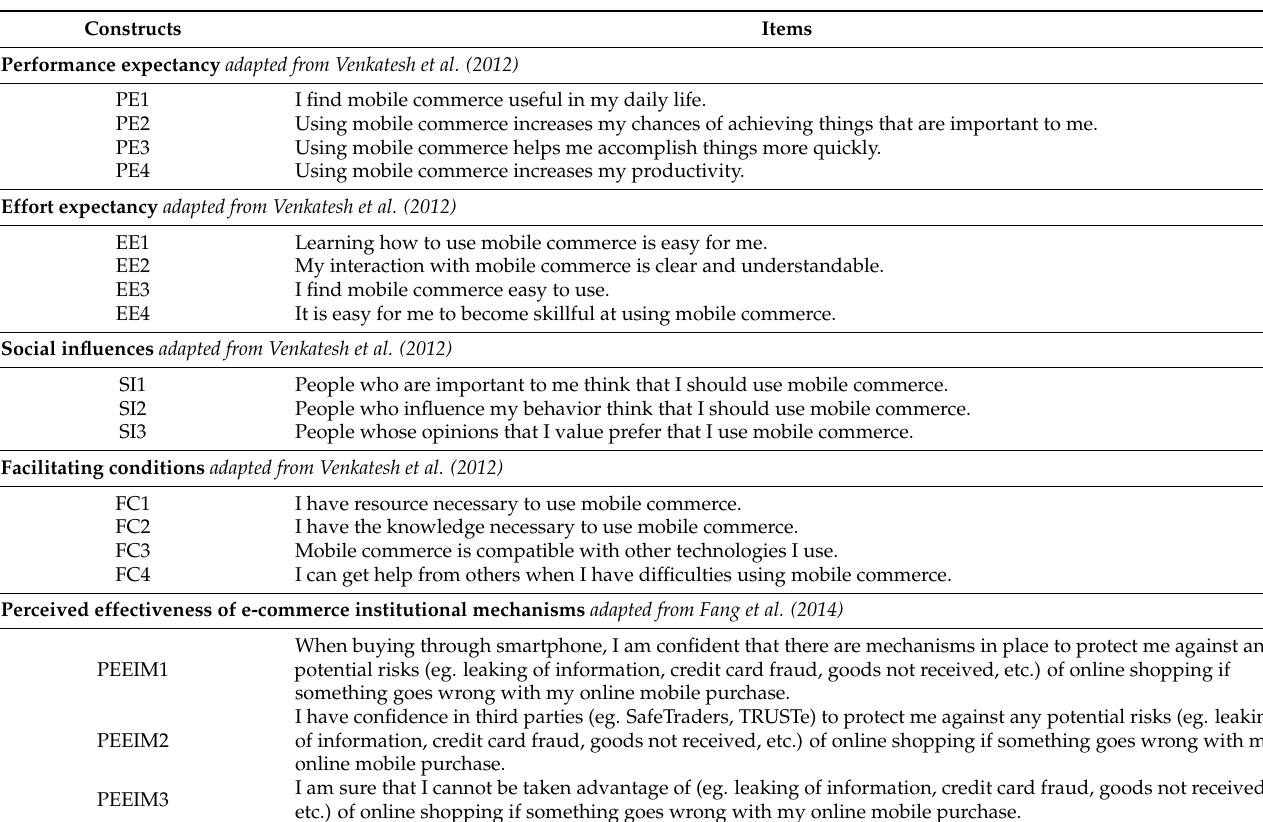
Figure A1. Structural model (baseline model without moderating effects). Table A1. Questionnaire design (constructs and sources of items).